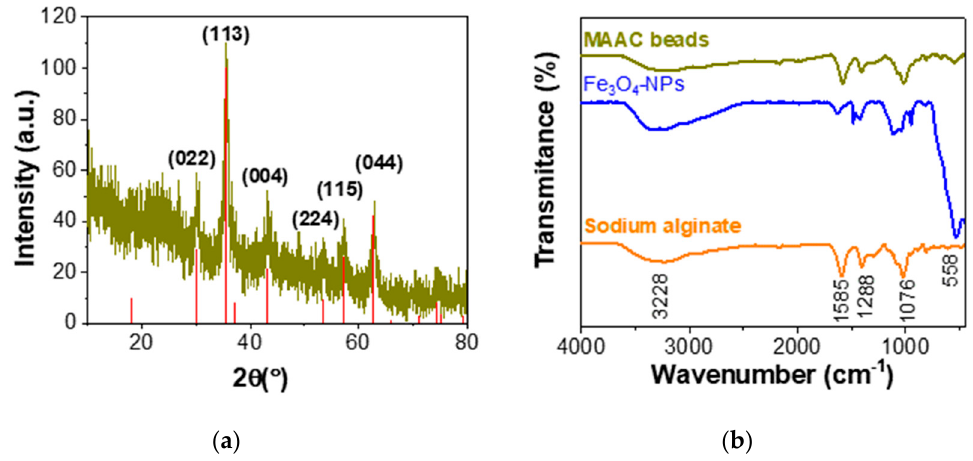
Figure 2. ( a ) X-ray diffraction and infrared spectra and ( b ) IR spectra of MAAC beads.